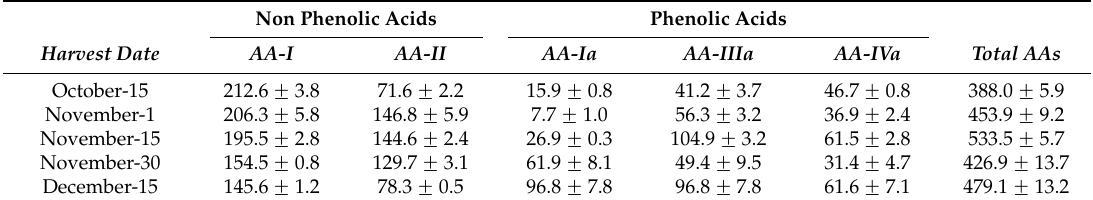
Table 1. Content (mg/kg, X ± SD) of AA-I ( 1 ), AA-II ( 2 ), AA-Ia ( 3 ), AA-IIIa ( 4 ) and AA-IVa ( 5 ) from samples of leaves of A. chilensis collected between October and December 2014.